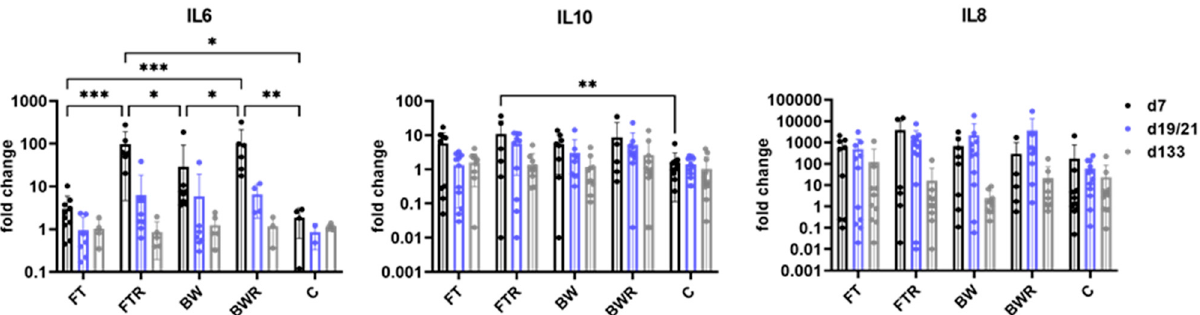
No other differences were observed in the IL10, and none at all in the IL8 analysis.